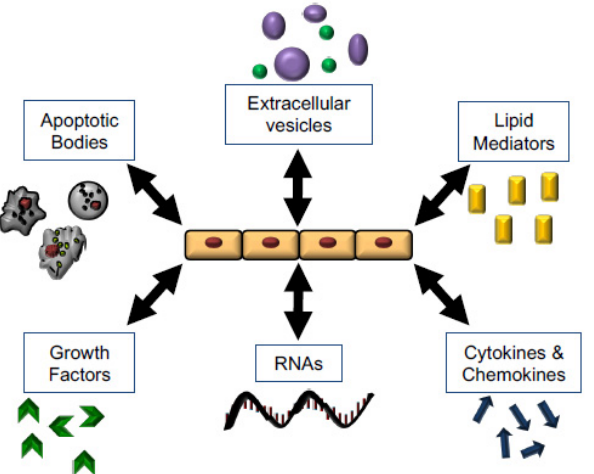
Figure 4. Mechanisms of Wound Healing and opportunities for therapeutic intervention. Epithelial cells regulate and respond to multiple stimuli which have the potential to mediate and promote tissue repair, including apoptotic bodies, microvesicles, lipid mediators, soluble signals, RNAs and miRNAs, and growth factors.